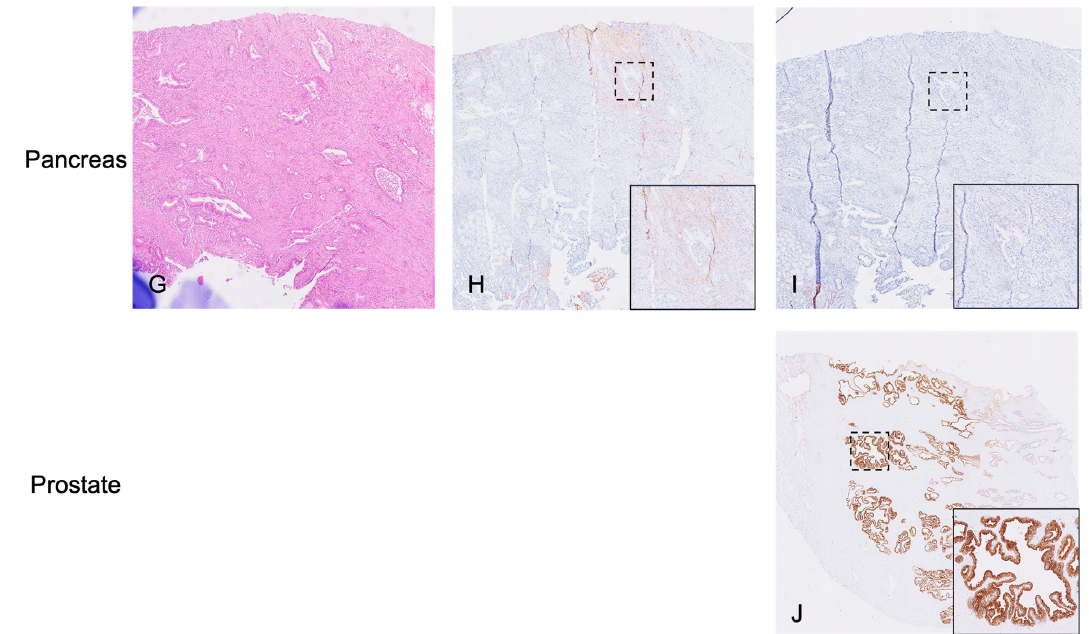
Figure 6. Overview of immunohistochemical stainings. This figure displays Hematoxylin and Eosin (HE), endoglin and PSMA staining of, respectively, colon (( A – C ), H ‐ score 120), gastric (( D – F ), H ‐ score 150) and pancreatic cancer (( G – I ), H ‐ score 0). As a positive control ,the PSMA staining was performed on prostate cancer tissue (( J ), H ‐ score 300). Overview images were made at 1–2× magni ‐ fication, zoom images at 10×